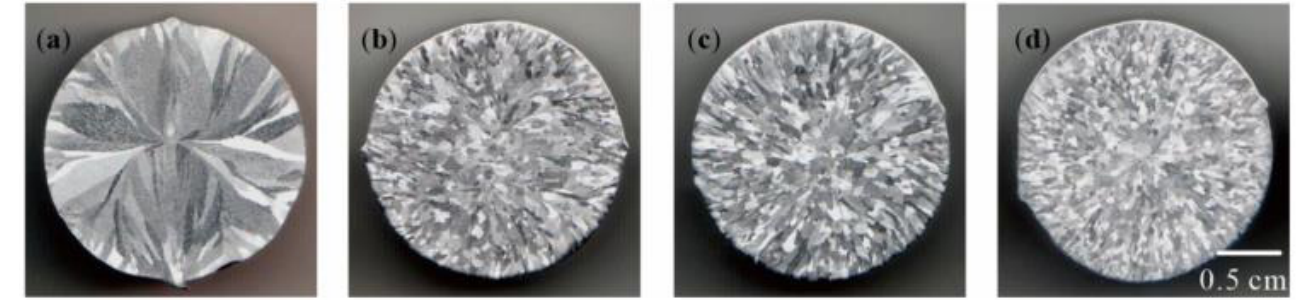
Figure 8. The refining effect of different Al–Ti–B Master Alloy on pure aluminum: ( a ) Pure aluminum; ( b ) 30% Ti-sponge route; ( c ) Ti-sponge route; ( d ) halide salt route.